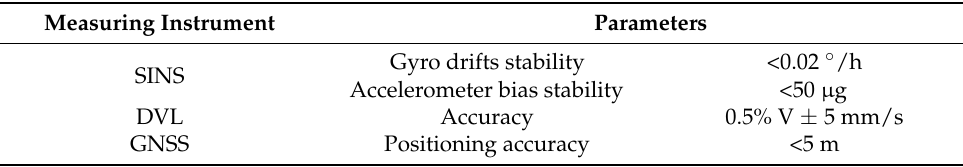
Table 1. The parameters of the measuring instrument.